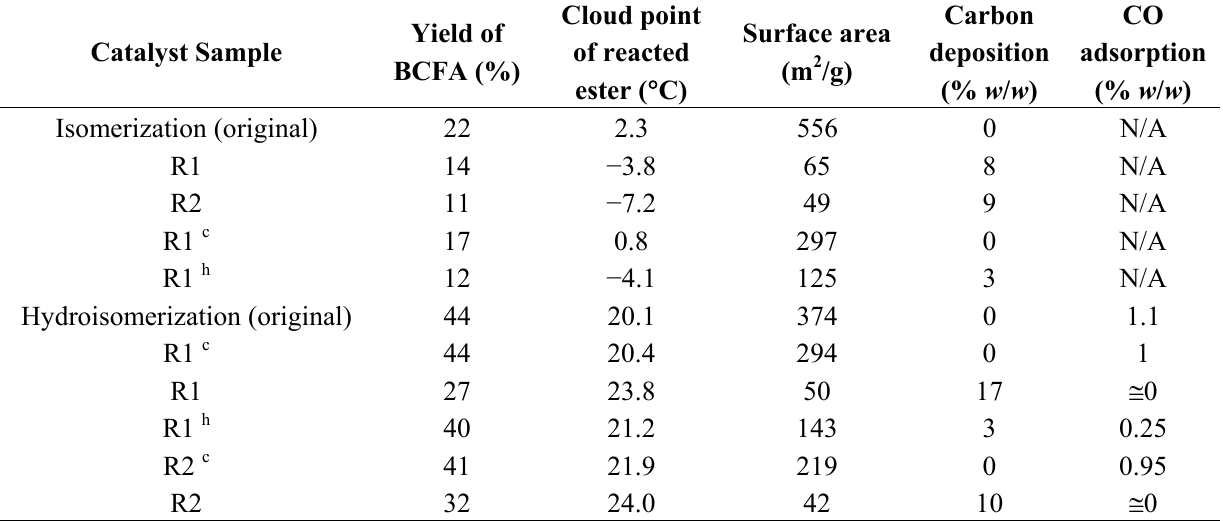
Table 4. Physical properties of isomerization and hydroisomerization catalysts before and after the